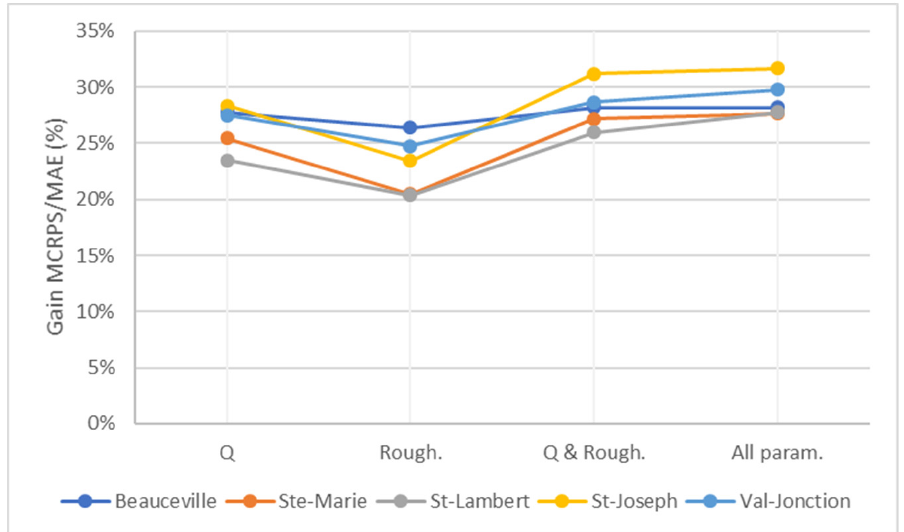
Figure 13. Mean continuous rank probability score (MCRPS) gain in % over the mean absolute error (MAE) for various locations and ensemble subsets.